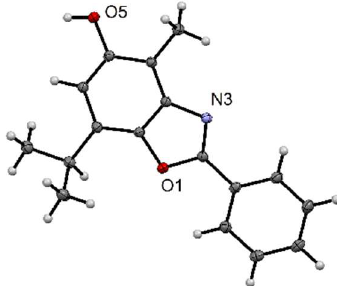
Figure 2. ORTEP view of compound 1a with heteroatom labelling. Thermal ellipsoids are drawn at 50% probability level.